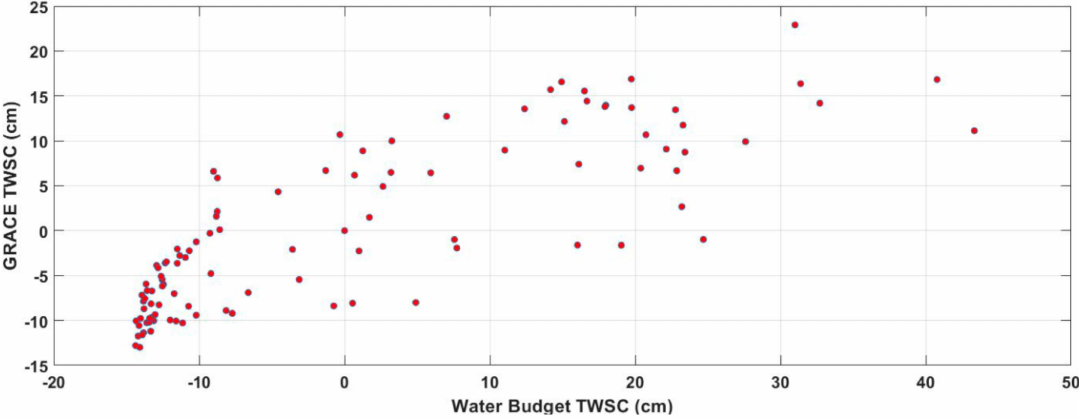
Figure 6. Scatterplot for GRACE TWSC and water budget-derived TWSC.